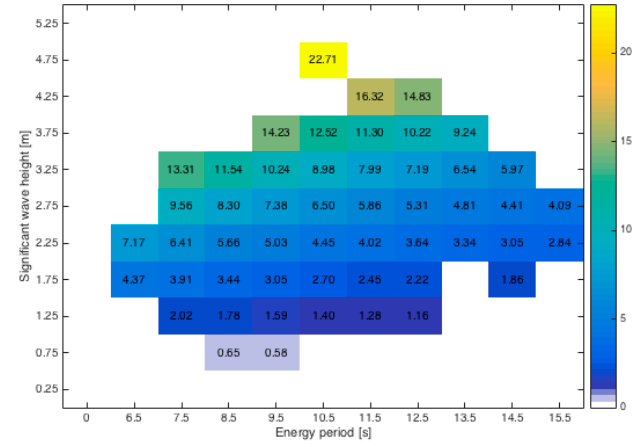
Figure 8. Corresponding energy matrix in kW on the west coast of Scotland (centre of area is at 57° N, 9° W).